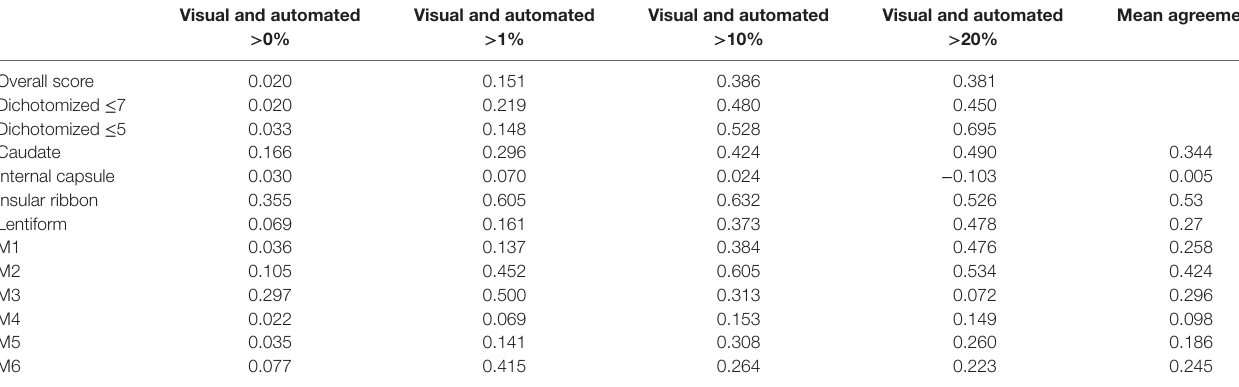
TaBle 3 | Agreement between visual and automated scoring for total Alberta Stroke Program Early Computed Tomography Score (ASPECTS) ( κ w ), dichotomized for ≤ 7, and ≤ 5 thresholds and each ASPECTS region ( κ ).